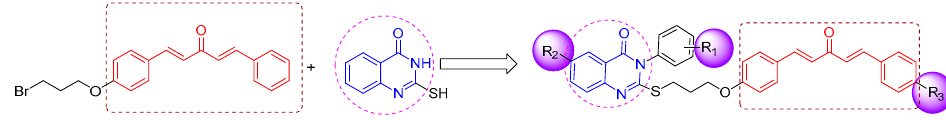
Figure 2. Design of the target compounds.